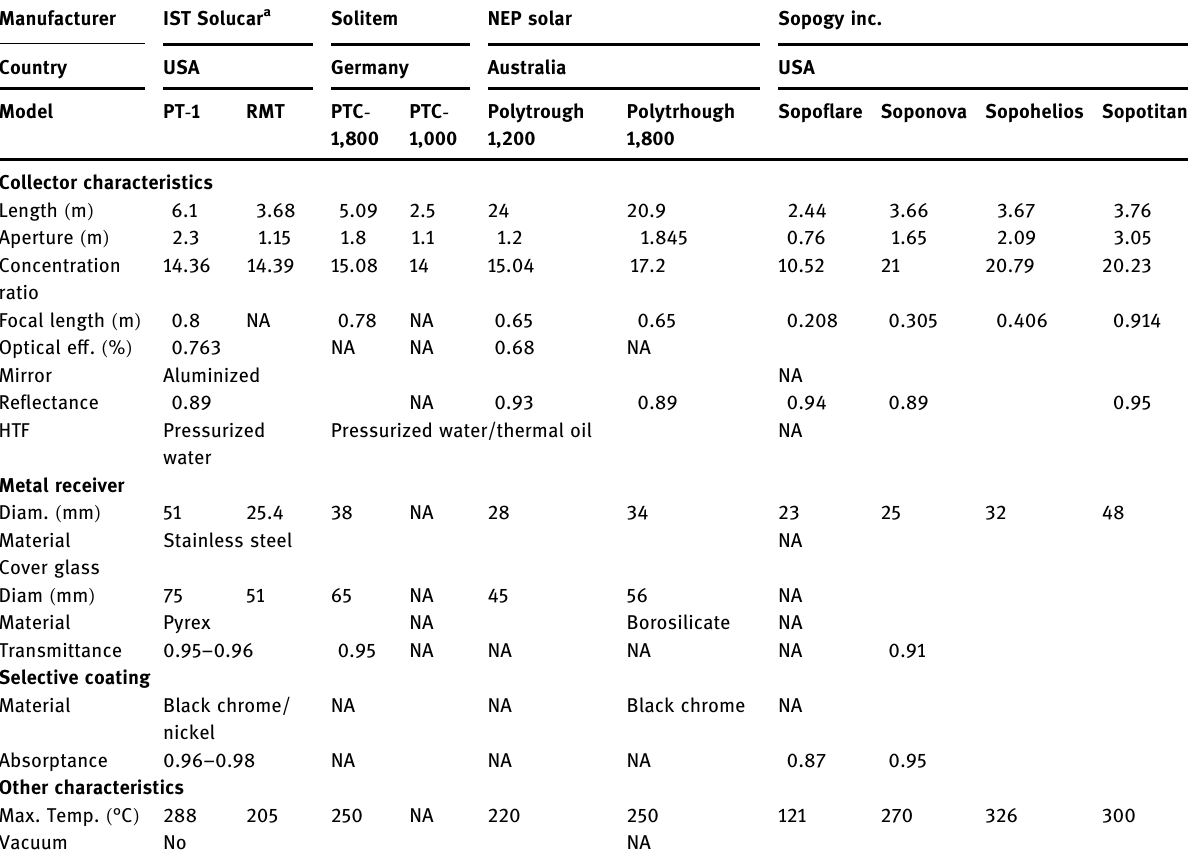
Table 6: Characteristics of some small - aperture collectors [ 58 – 61